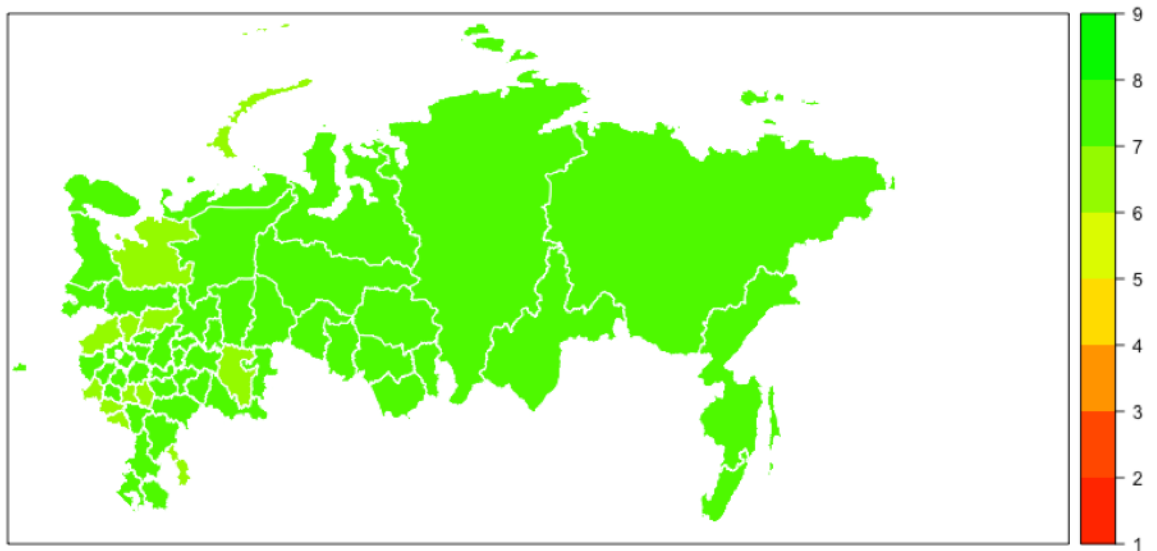
Figure 5. Map of Russia showing the levels of respondents’confidence in information and understanding. Areas with data from less than 40 respondents are not shown on the map. The combined median score on confidence in information and understanding was used (Question [Q]1. I feel informed about COVID-19; Q2. I feel informed about measures to prevent infection with COVID-19; Q3. I understand the guidance from health care authorities related to COVID-19). Respondents were provided with a 9-point Likert scale, where 1 is completely disagree and 9 is completely agree.